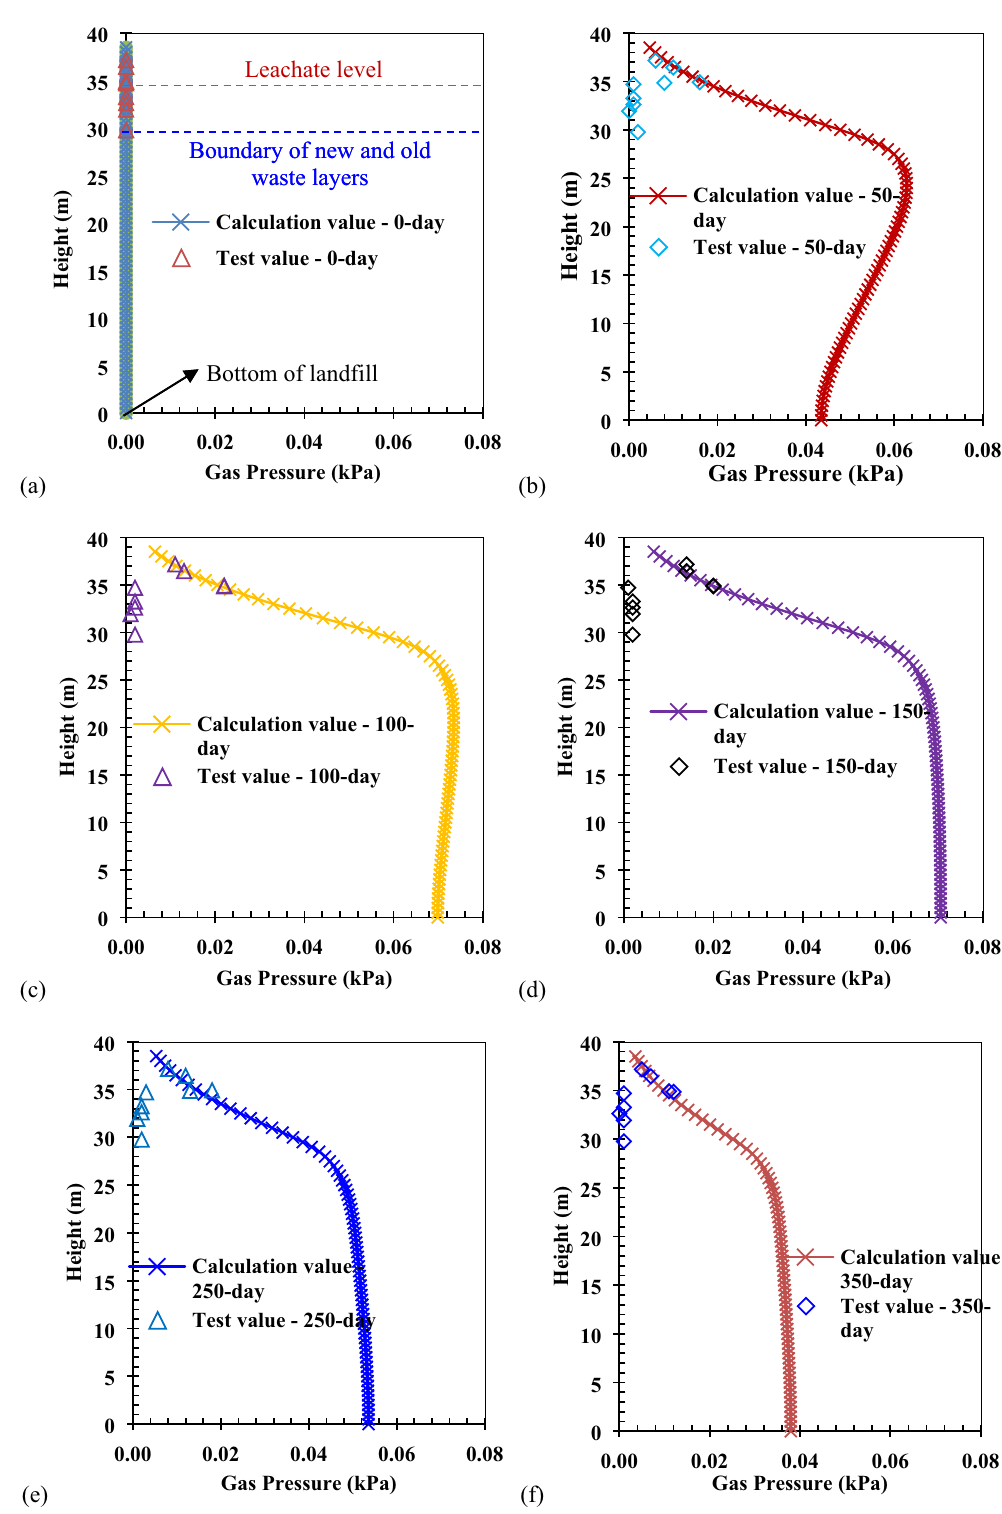
Figure 6. Comparison of calculation and test values of gas pressure with height on the different time: ( a ) day 0; ( b ) day 50; ( c ) day 100; ( d ) day 150; ( e ) day 250; ( f ) day